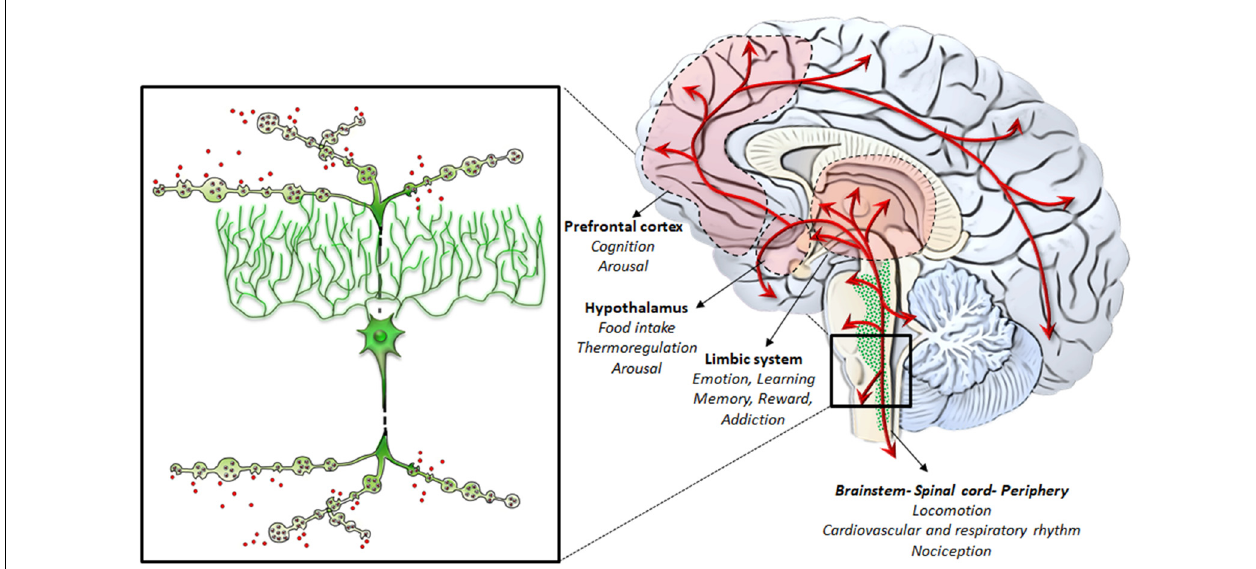
FIGURE 3 | NE-containing neurons of the RF: from gross anatomy to the fine iso-dendritic nature. NE-containing neurons of the RF profusely branch their axons to release NE throughout the whole central nervous system (CNS) and the autonomic nervous system. This is grounded on the typical fine neuroanatomy of NE fibers. In fact, apart from the marked spreading of axonal projections due to a profuse collateralization (which is typical for neurons forming the iso-dendritic core of the RF), axon collaterals are gifted with varicosities, also named “boutons en passage.” This is key in the case of AMPHs, which promote massive NE release while impairing NE uptake. This allows NE to be released in the extracellular medium from each varicosity along the course of axon fibers to produce extra-synaptic, paracrine effects, even remotely from the release site via volume transmission. Altogether, these features synergize to produce widespread extra-synaptic effects following AMPHs-induced NE release in each brain area. This explains why AMPHs activate wide brain areas leading at the same time to different behavioral, motor and vegetative effects. These include the limbic system, the hypothalamus, the prefrontal cortex, as well as the whole brainstem, spinal cord and peripheral organs receiving NE sympathetic innervation.